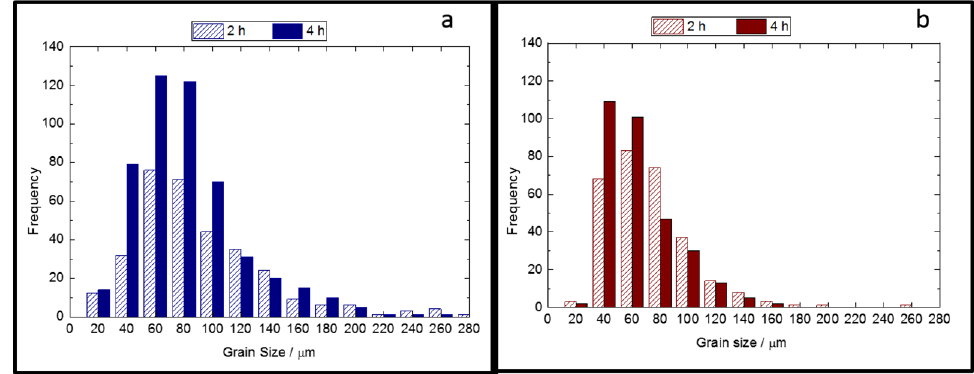
Figure 7. Histograms showing the particle size distribution obtained for AA7075-MWCNTs com- posite particles with both MWCNT percentages at 2 h and 4 h of HEBM: ( a ) 0.5 wt.% MWCNT and ( b ) 1 wt.% MWCNT.